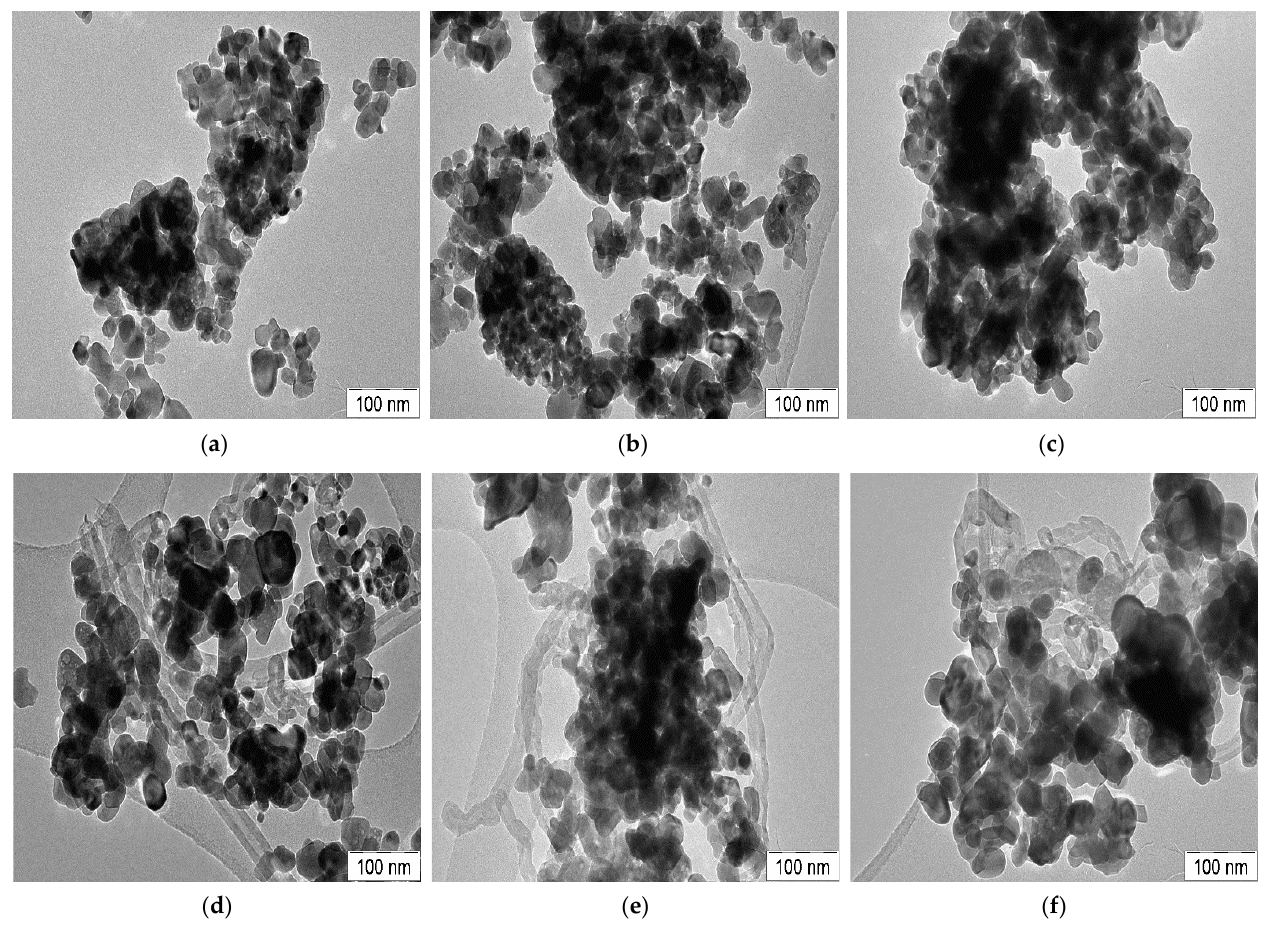
Figure 9. TGA plot for promoted used catalysts at 700 °C after 440 min.